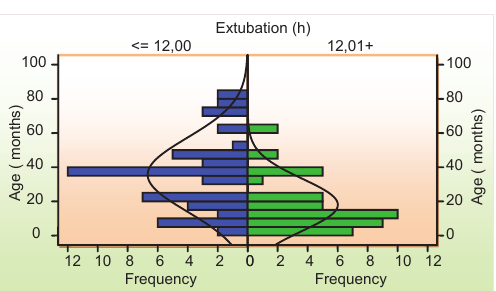
FIGURE 3. Extracorporeal circulation (ECC) time as marker for prediction successful early extubation, with cut off 45.5 minutes (sensitivity 71% and specificity